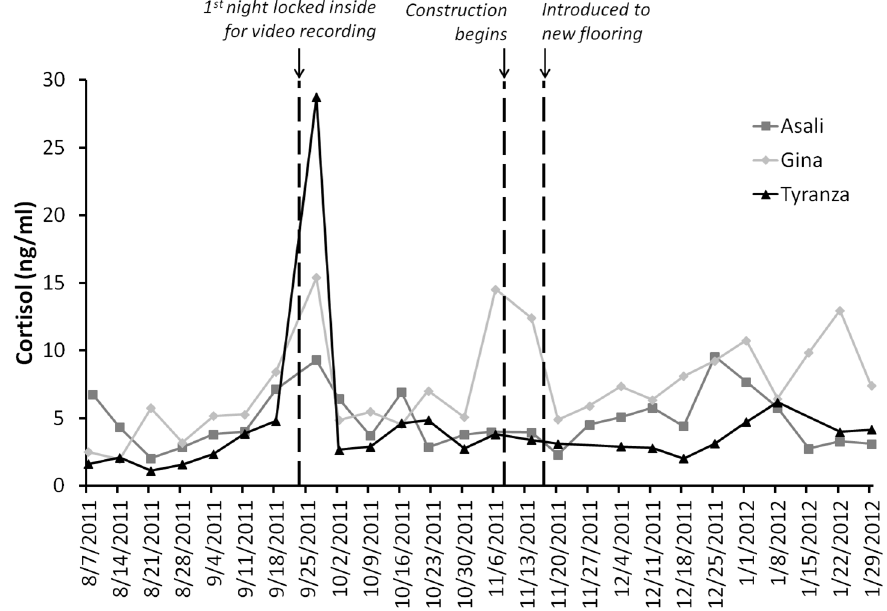
Fig 6. Cortisol (ng/ml) profile for three female African elephants. Profiles represent before (8/7/2011 to 11/7/2011), during (11/8/2011 to 11/15/2011), and after (11/16/2011 to 1/29/2012) renovation to the elephant